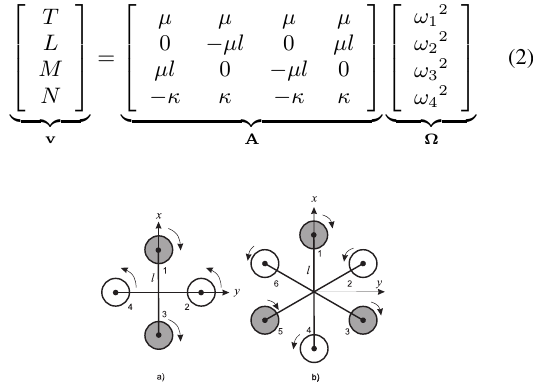
Figure 3: Multi-rotor helicopter configurations: quadricopter in a), hexacopter in